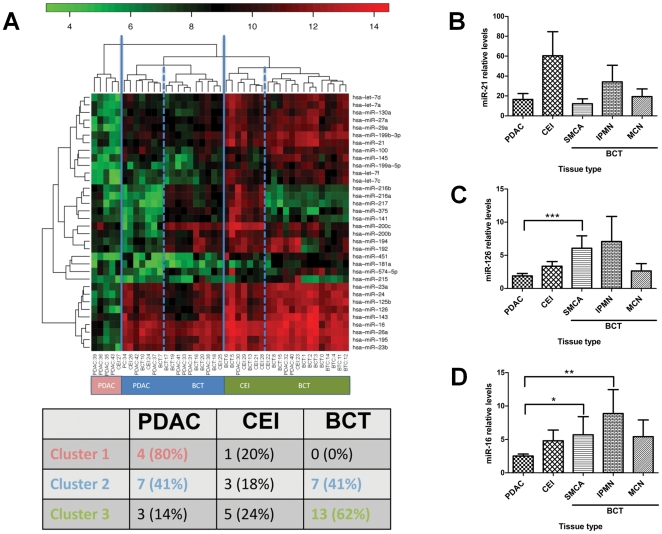
A subset of miRNAs are down-regulated in PDAC compared to Benign Cystic Tumors (BCT).(A) Hierarchical Clustering Heatmap was created to detect possible clusters in rows (transcripts) and columns (samples) of the normalized expression matrix. For this analysis we used the 35 miRNAs with highest overall variability. As the heatmap, with its dendrogram on top and the contingency table at the bottom, shows we detect three clusters indicated by the solid blue lines. The first cluster consists of 80% PDAC, 20% CEI and no BCT samples and thus contains predominantly PDAC samples. The second cluster contains 41% PDAC, 41% BCT and 18% CEI samples. Subdividing it into two additional clusters, as indicated by the dashed blue lines, we see that the left part consists predominantly of CEI, while the right part entails a slight enrichment for BCT samples. Finally, the third cluster contains 14% PDAC, 24% CEI and 62% BCT samples, thus consists predominantly of BCT samples (P = 0.034). (Red indicates high intensity; green indicates low intensity; PDAC, Pancreatic Ductal Adenocarcinoma; CEI, Carcinoma-Ex-IPMN; BCT, Benign-Cystic-Tumors). (B) miR-21 (C) miR-126 and (D) miR-16 were measured using RT-qPCR, performed on the 43 FFPE tissues in order to validate the microarray data. Samples included: SMCA (n = 7), MCN (n = 6), IPMN (n = 7), and CEI (n = 9) and PDAC (n = 14). (Results presented as mean±SEM; *** P = 0.003, ** P = 0.02 and * P = 0.05 respectively).